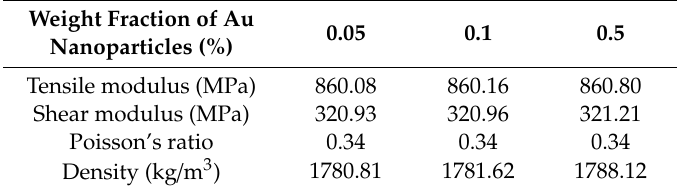
Table 3. Predicted mechanical properties of PVDF-Au nanoparticles nanocomposite at di ff erent weight